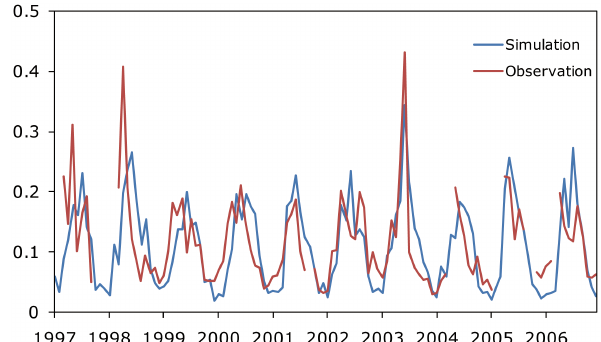
Figure 4. Comparison between the simulated variation of the monthly mean dust AOD in the control experiment and the AERONET-observed variation of the monthly mean aerosol AOD (500nm) at Dalanzadgad from 1997 to 2006 ( r = 0 .